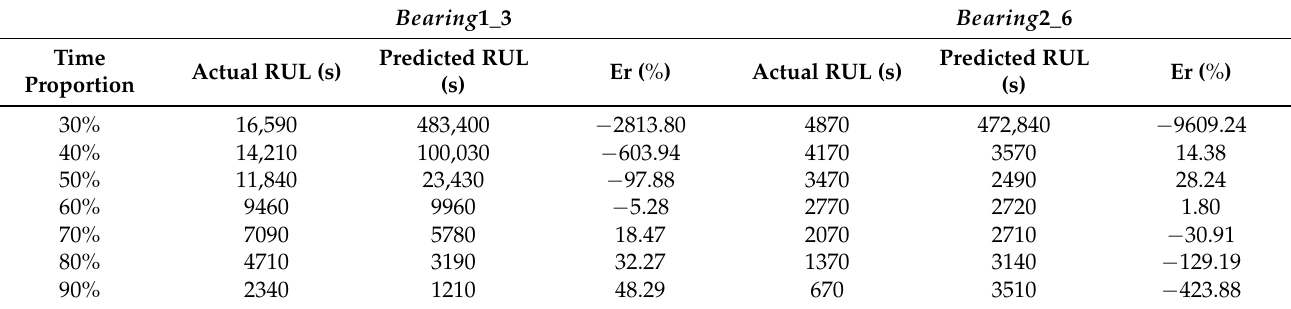
Table 2. RUL prediction results under different historical data percentages.